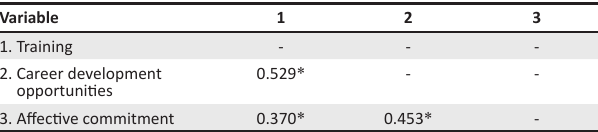
TABLE 3: Relationship between training, career development opportunities, and affective commitment. Variable 1 2